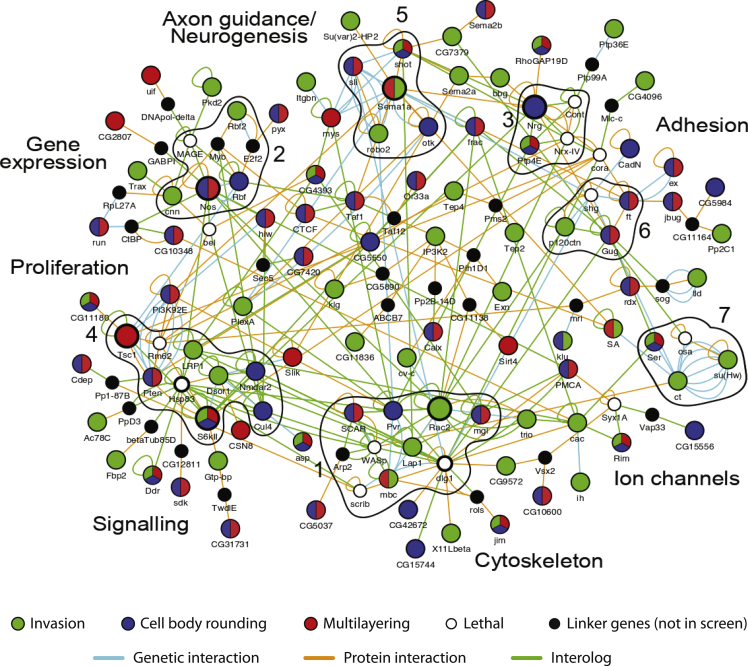
An Interaction Network of Invasion SuppressorsInteractions between genes for which KD enhanced the categories “invasion,” “multilayering,” and “cell body rounding” are shown. Each circle node represents a gene. Node color indicates phenotype observed in the screen: green, invasion; blue, cell-body rounding; red, multilayering; multi-coloured nodes, genes that were hits for more than one phenotype; white, lethal; black, “linker genes,” i.e., genes that were not part of the screen, but that connect screen hit genes by one interaction; nodes with a bold outline, hub genes in this network. Lines represent interactions: cyan, genetic; orange, protein-protein; green, interolog. MCODE complexes of highly interconnected genes are outlined in black. Significantly enriched GO terms are indicated. See also Data S1.